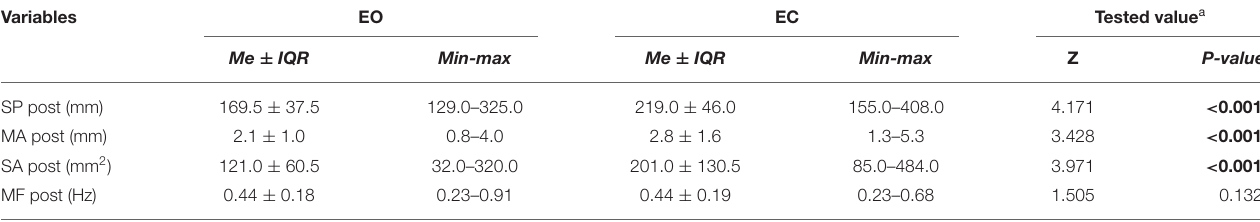
TABLE 2 | The descriptive statistics and differences in results of the post-exposure postural stability tests with eyes open (EO) and eyes closed (EC).